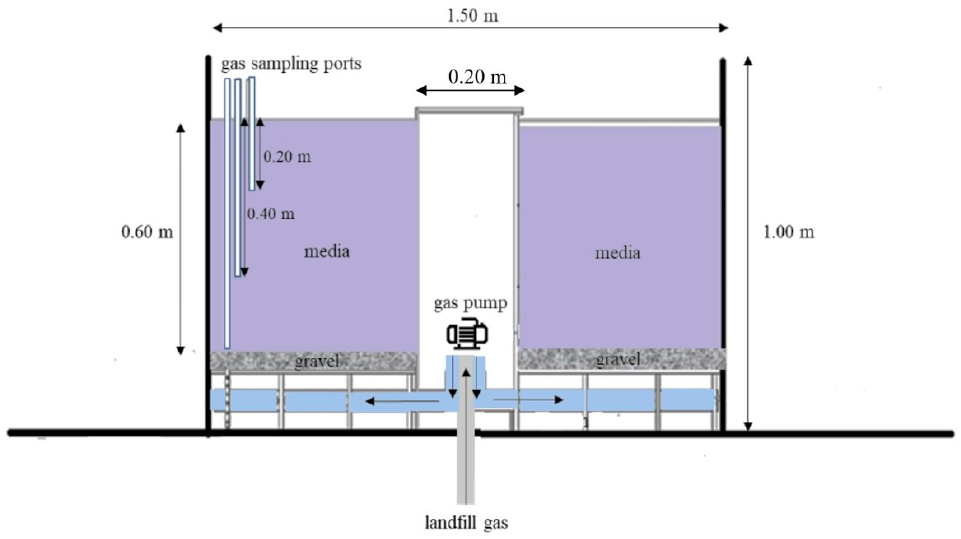
Figure 1. Schematic of bio-cover unit. Table 1. Physical and chemical characteristics of bio-cover materials .